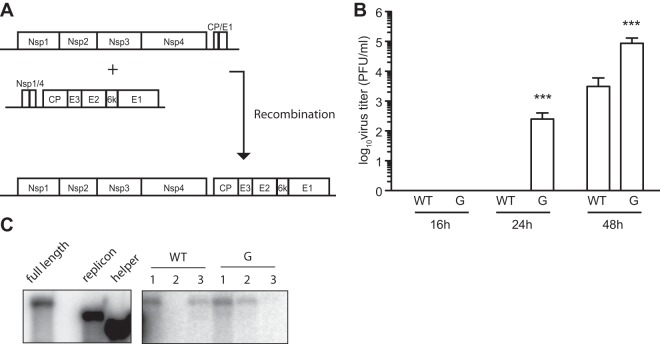
RdRp mutators have higher recombination rates than wild-type virus. (A) Schematic of the recombination experiment: BHK-21 cells were cotransfected with an equal amount of replicon RNA and helper RNA. Titer was assessed by plaque assay. (B) BHK-21 cells were cotransfected with SINV-helper and with replicon-WT or replicon-G. At 16, 24, and 48 h posttransfection, progeny viruses arising from recombination were quantified by plaque assay. Mean values and standard errors of the means are shown (n = 3; ***, P < 0.001, by a two-tailed student t test). (C) BHK-21 cells were infected with progeny collected from the recombination experiment presented in panel B and probed by Northern blotting using a probe able to recognize full-length, replicon, and helper genomes.